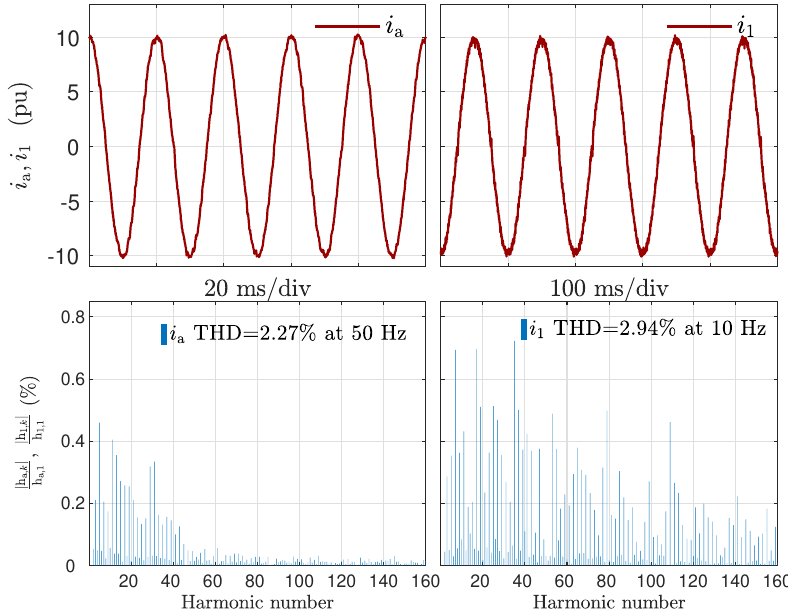
Figure 23. Spectrum of i a , i 1 and THD calculations, when NLC modulation technique is utilized. 9.4. Single–Phase Current THD Assessment under PD–SPWM Single–phase current i a is depicted in the top–left section of Figure 24. Likewise, the at each PCC. The harmonic distortion computation of single–phase currents indicate THD values of 3.19% and 4.52%, respectively. THD values of PD–SPWM are higher than NLC in 40.6% and 54% each. Be aware that i 1 harmonic number 5th = 50 Hz features the highest amplitude of 2.3% under PD–SPWM.